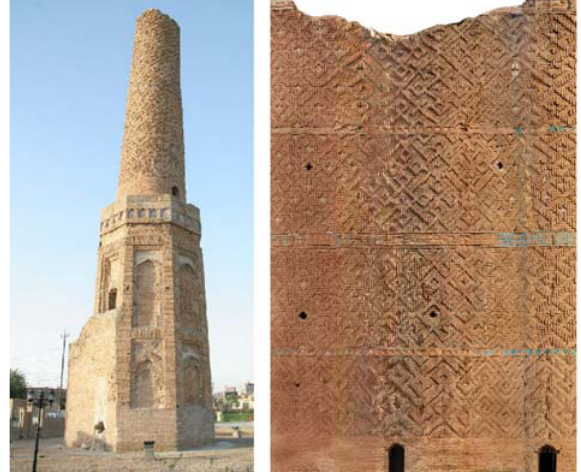
Figure 2. Minaret Choli, Erbil / Iraq; complex view and tube un- wrapping (Pavelka, 2007).